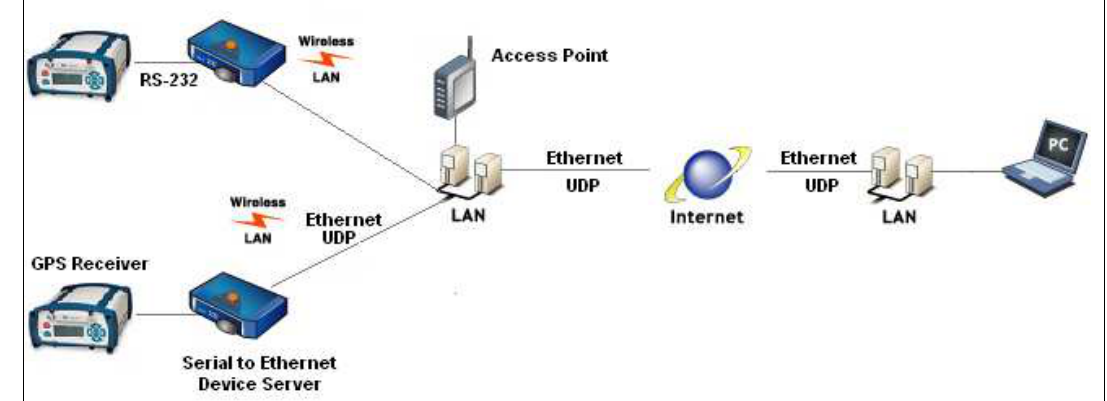
Figure 6. Ethernet based design (based on [11]).